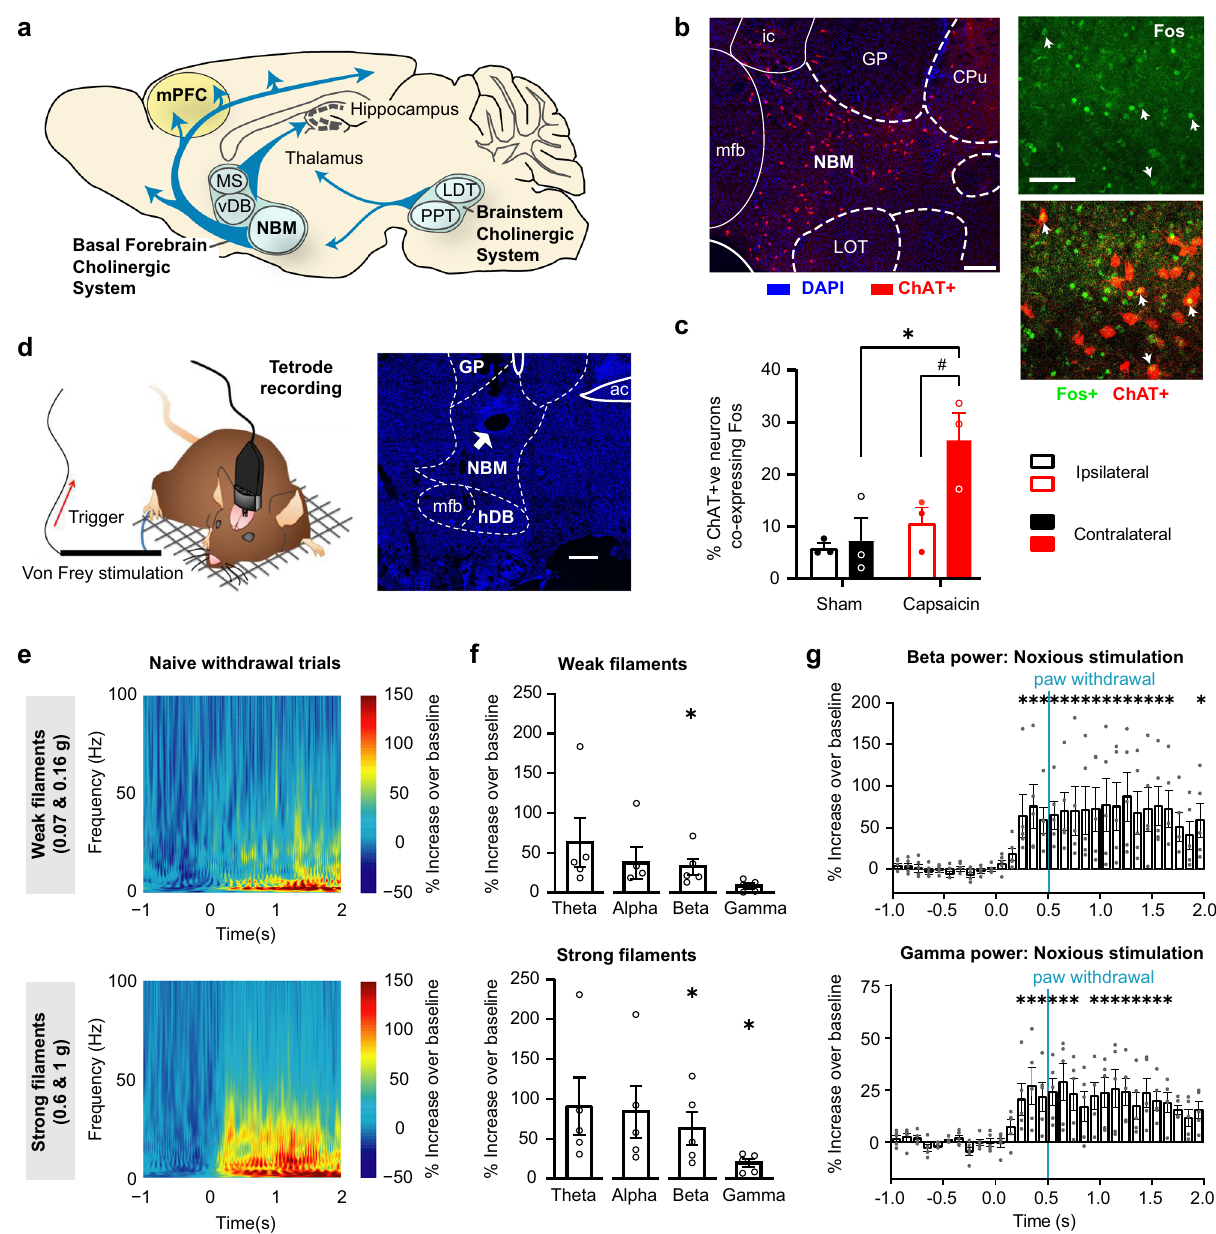
Fig. 1 | Recruitment ofthe Nucleus Basalis ofMeynert (NBM), a basal forebrain cholinergic nucleus, by noxious stimuli eliciting pain-like behavior. a Schematic of the main cholinergic nuclei in mouse brain ( b , c ) Typical examples ( a ) and quanti fi cation ( b ) of capsaicin-induced increase in Fos immunohis- tochemistryinNBMcholinergicneurons(ChAT+ve;arrows:co-labeledcells). n =3 mice/group; P <0.05 (*0.0103, #0.0263), two-way ANOVA with Sidak ’ s multiple comparisons test. d Schematic representation (sourced from ref. 31) of in vivo tetrode recordings in the NBM (white arrow: electrode tip lesion in section) in response to von Frey mechanical stimulation of hindpaw. e Mean time – frequency representationofspectralmodulationintheNBMforalltrialswithpaw-withdrawal responsetoeitherweak fi laments(0.07gand0.16g;)orstrong fi